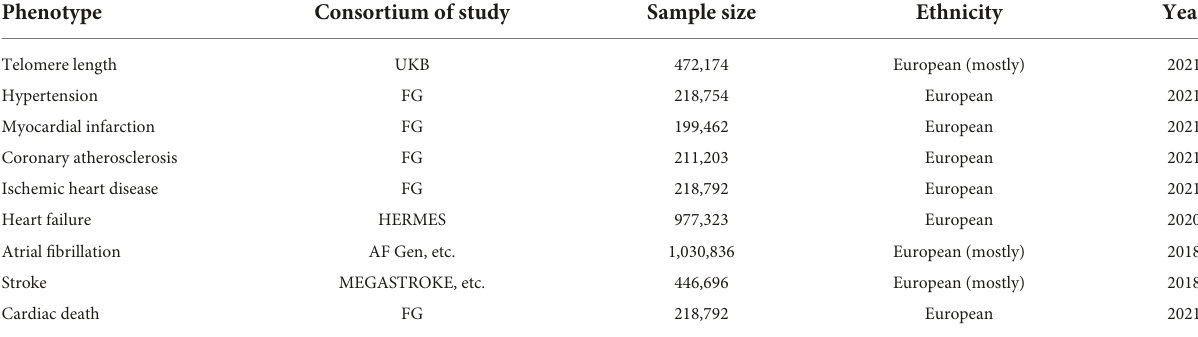
TABLE 1 Details of studies included in Mendelian randomization (MR)